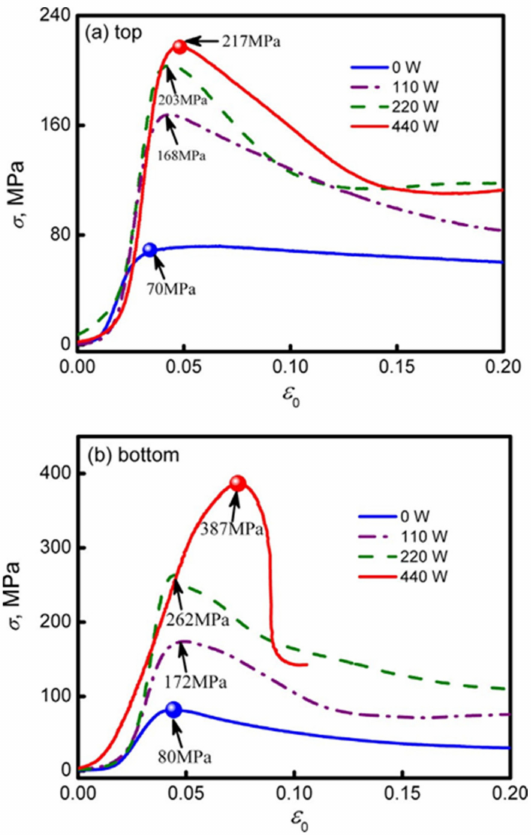
Figure 20. Compressive stress–strain curve for Cu-70 wt%Sn alloy that was solidified under static and ultrasonic conditions for the ( a ) sample top and ( b ) sample bottom [55]. On Cu-14.5 wt% Sn, Cu-21.3 wt% Sn and Cu-26.8 wt% Sn peritectic alloys, Kohler et al.